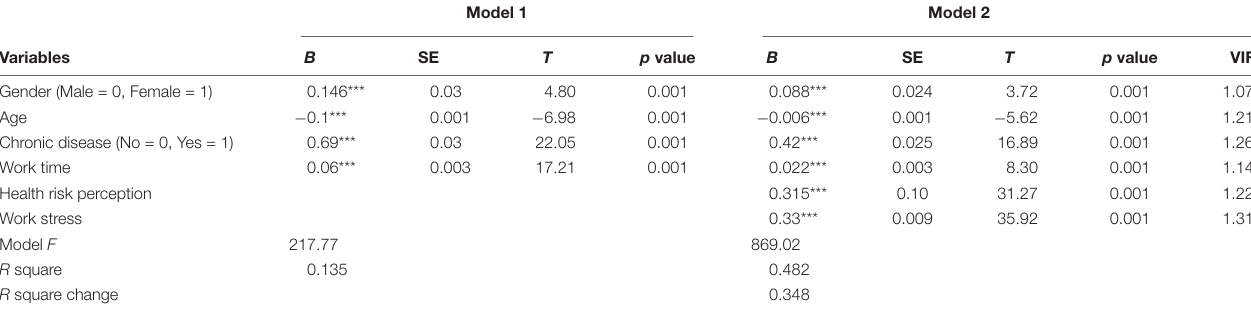
TABLE 7 | OLS regression analysis of factors influencing psychological